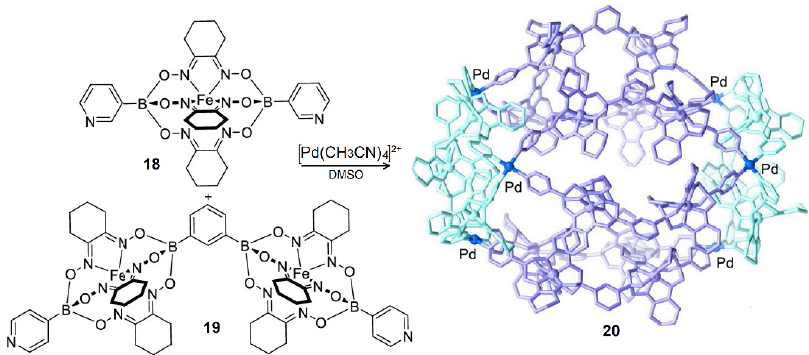
Figure 12. Structures of metalloligands 18 and 19 and the resulting [Pd 6 L 6 L ′ 6 ] 12+ cage 20 . Adapted with permission from [121]. Copyright (2021) American Chemical Society.